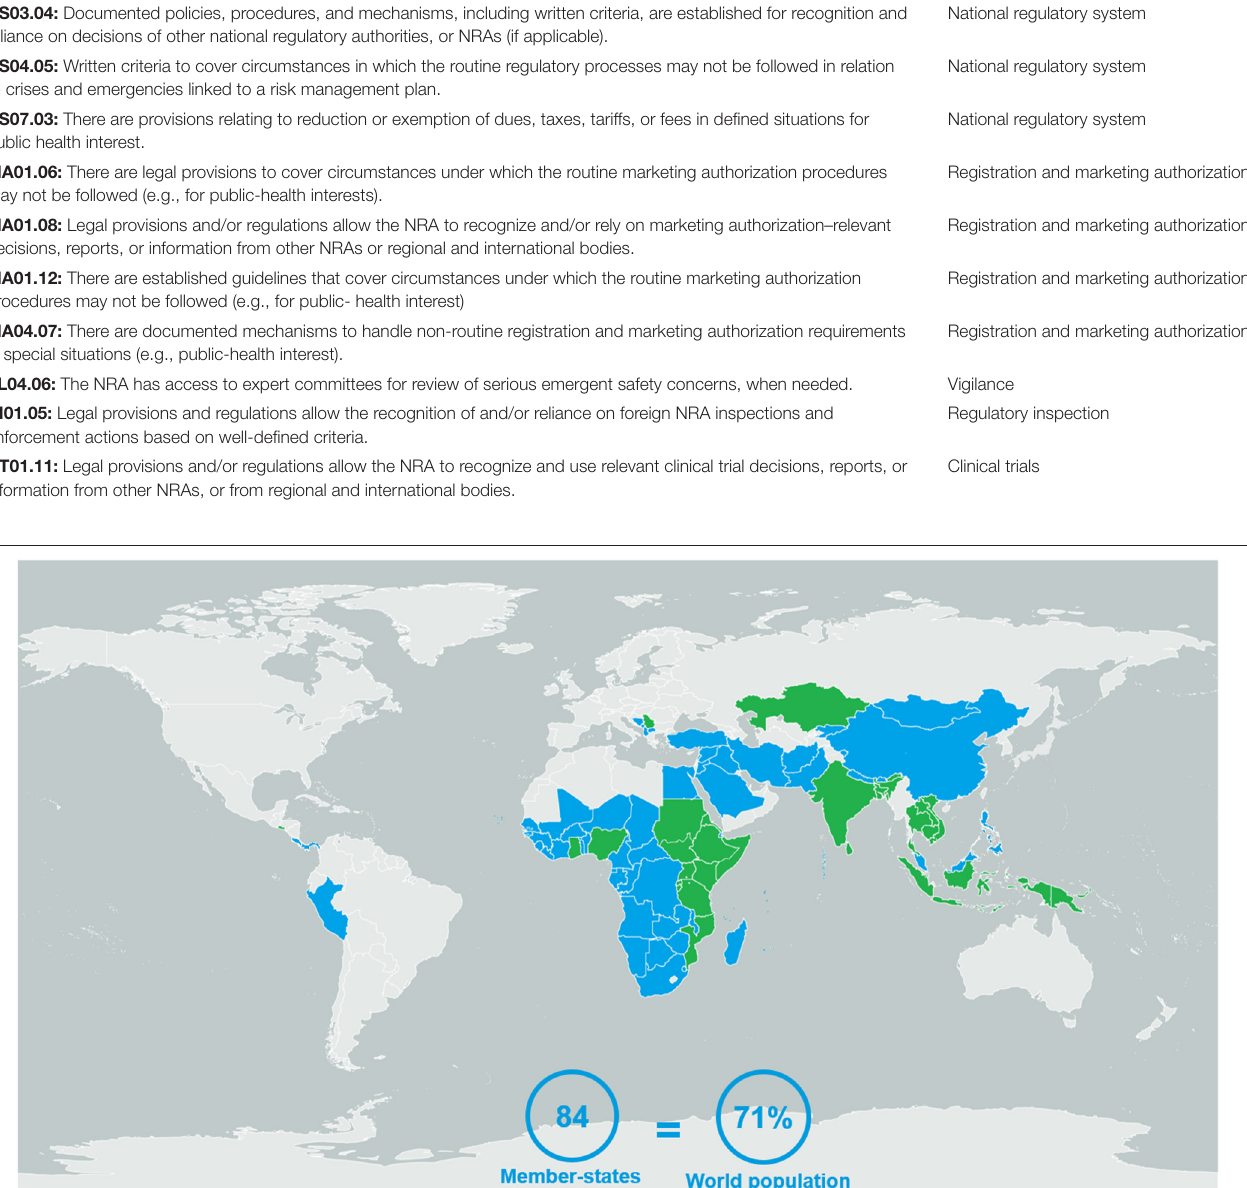
be linked back to an individual country would be shared outside of